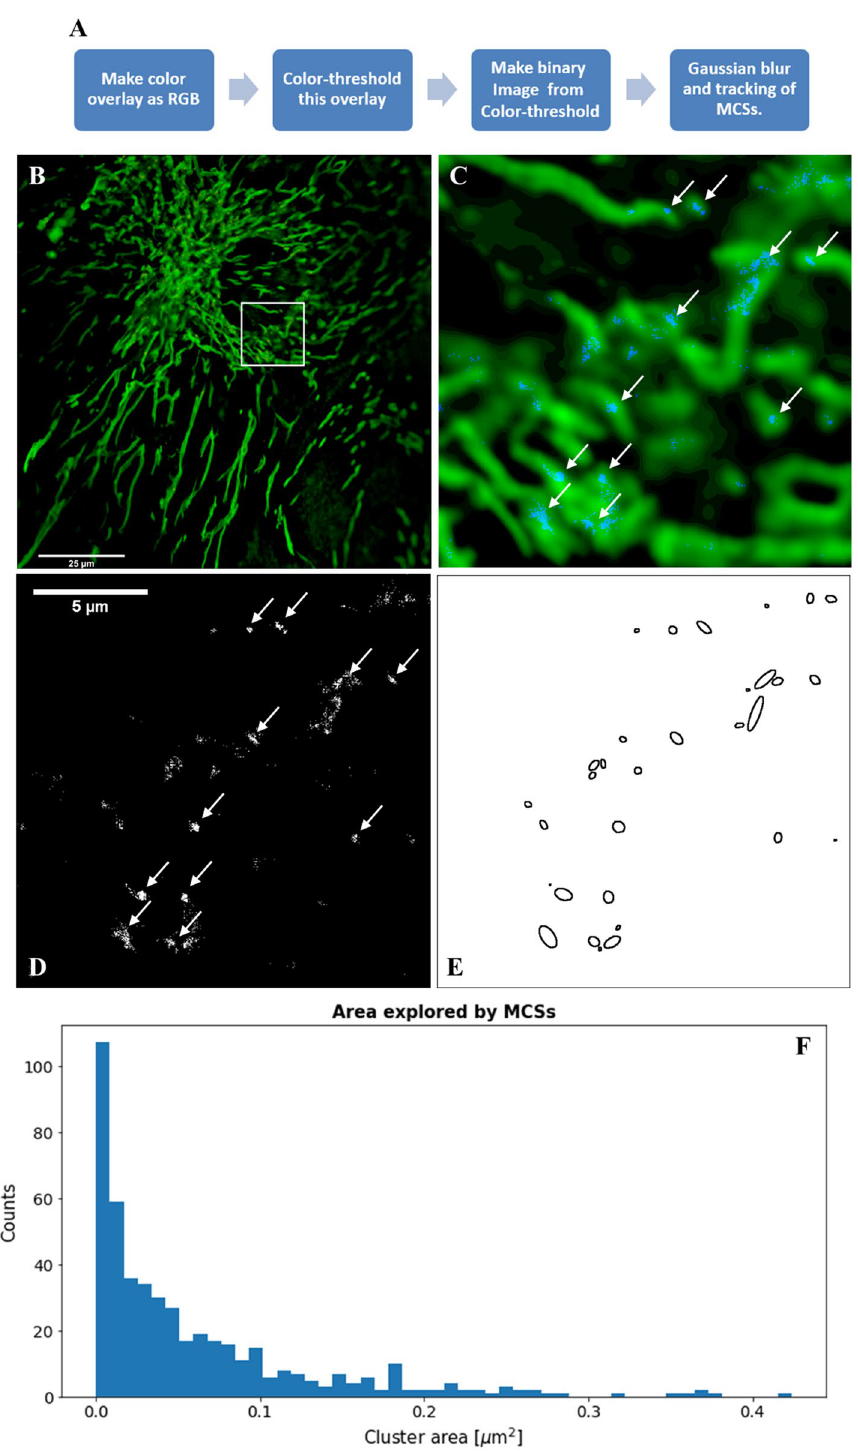
Figure 8. Localization microscopy reveals dynamic clusters of membrane contact sites. Workflow of the analysis is shown in A . Positions of MCSs identified using the segmentation procedure shown in panel A were localized using a 2D Gaussian fit and projected onto the sum projection image of mitochondria from a 3-min video recording. B , overview with mitochondria in green and positions of MCSs in blue. Bar, 25 µm. The 18 × 18 µm white box is enlarged in C , such that the blue positions of MCSs appear as small clusters on top of green mitochondria. D , map of identified positions of MCSs from whole video sequence showing dynamic clusters of all projected contact site locations. E , ellipses indicate dynamic clusters identified as individual objects for size analysis shown as histogram in panel F for a total of four analyzed